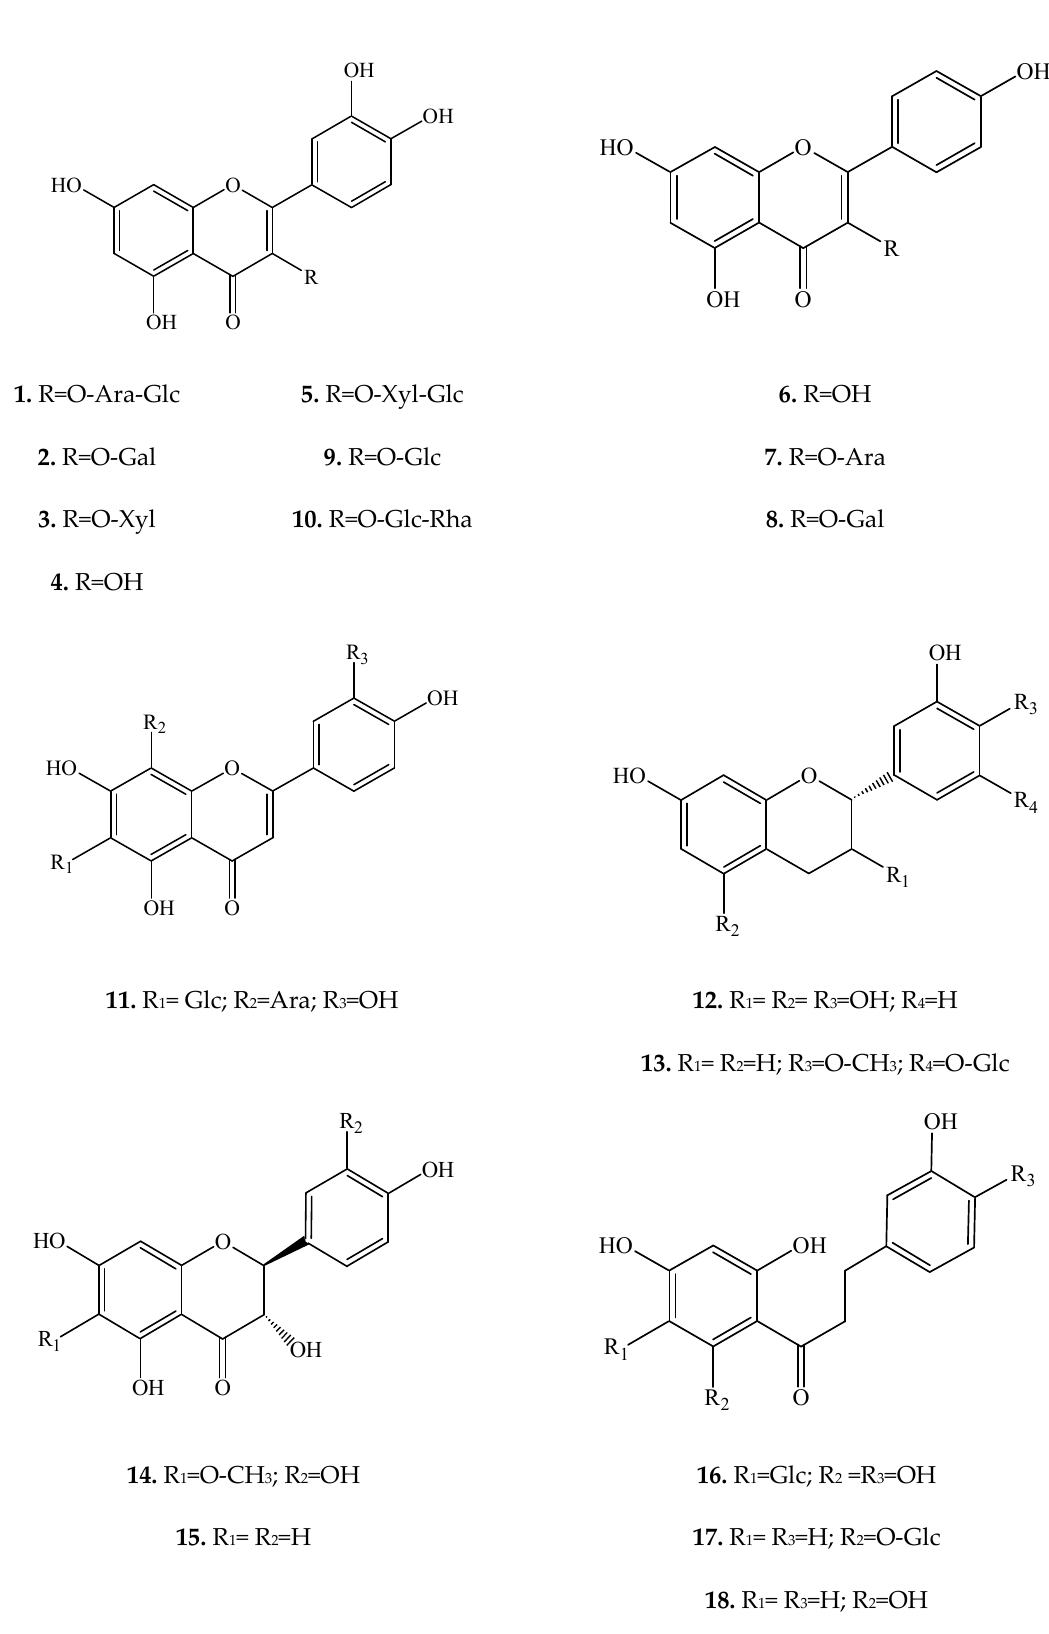
Figure 1. Structures of compounds 1 – 18 in E. longistipitata . Ara: arabinopyranose; Gal: galactopyranose; Xyl: xylopyranose; Glc: glucopyranose; Rha: rhamnopyranose.